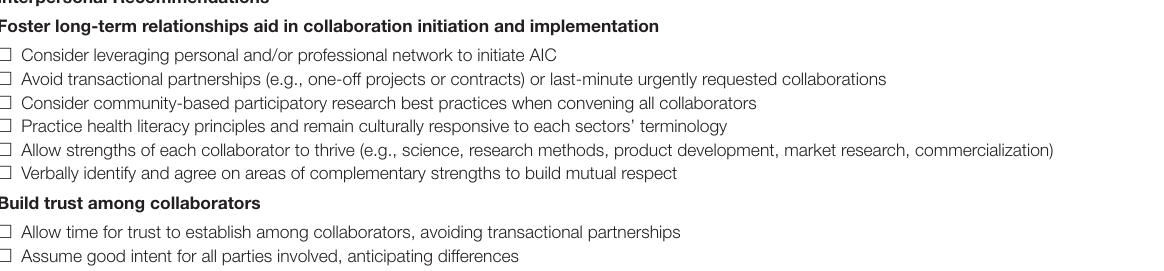
TABLE 1 | Checklist of Recommendations for Digital Health AIC. Interpersonal